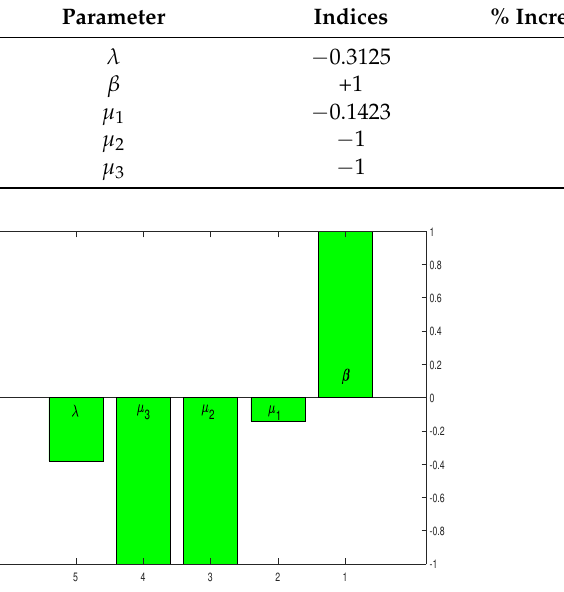
Figure 2. Graphical representation of the outcome in Table